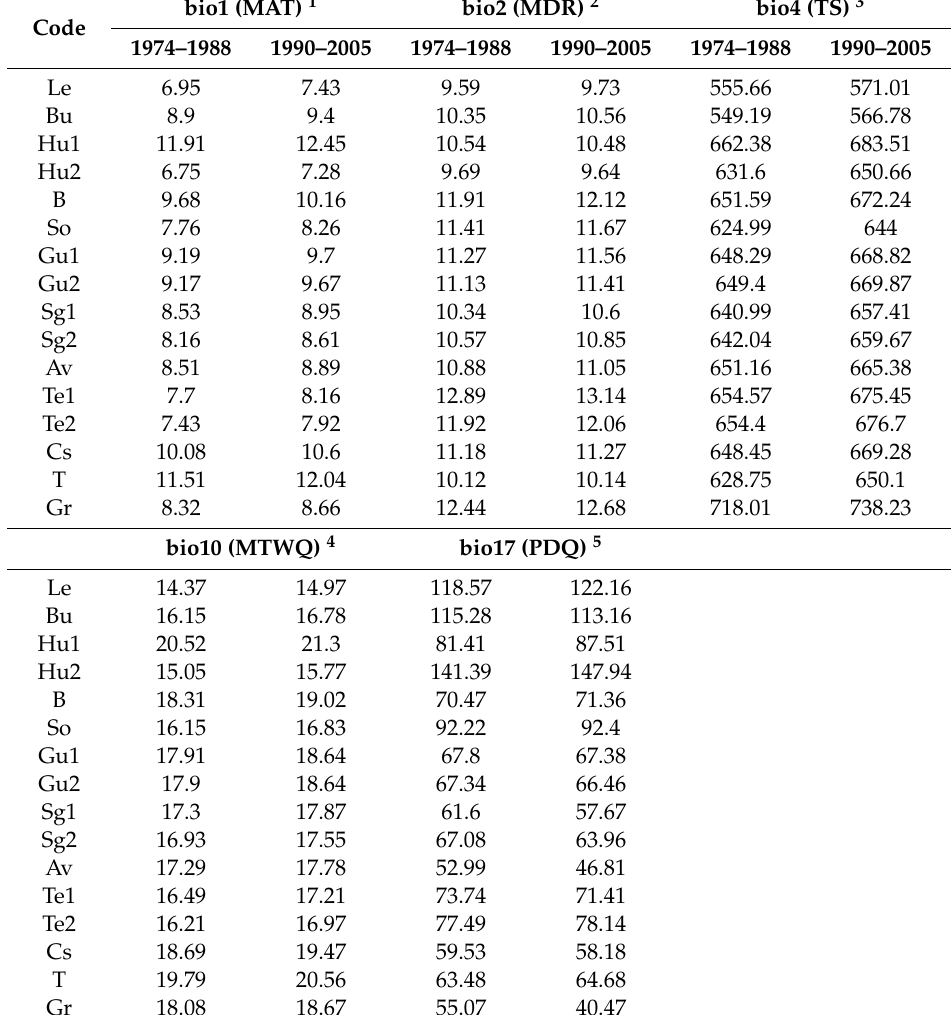
Table A2. Mean of the Provenance’s climatic indices for the di ff erent period considered in the study.